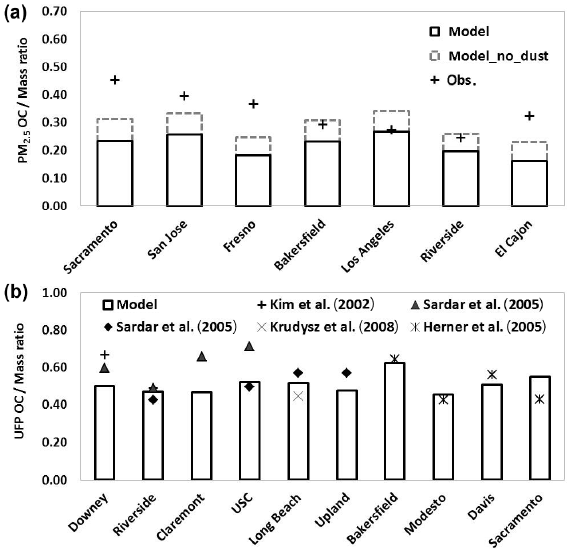
Figure 2. Observed (obs) and predicted (model) OC / mass ratios in (a) PM 2 . 5 and (b) ultrafine and quasi-ultrafine PM. In (a) , a sensitivity analysis is conducted by removing the dust concentra- tion from the PM 2 . 5 total mass (model_no_dust). The ultrafine and quasi-ultrafine data in (b) are extracted from published literature as indicated in the figure.